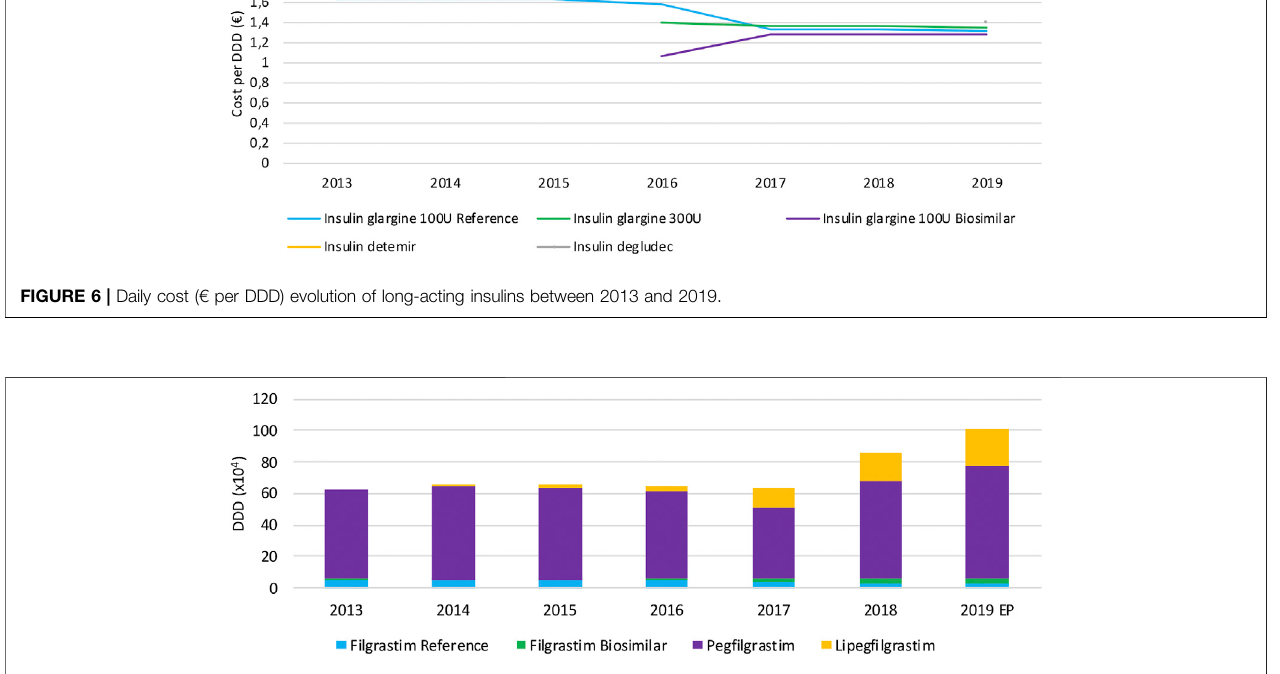
FIGURE 7 | Total volume (DDD) evolution of G-CSFs between 2013 and 2019. EP: Extrapolated